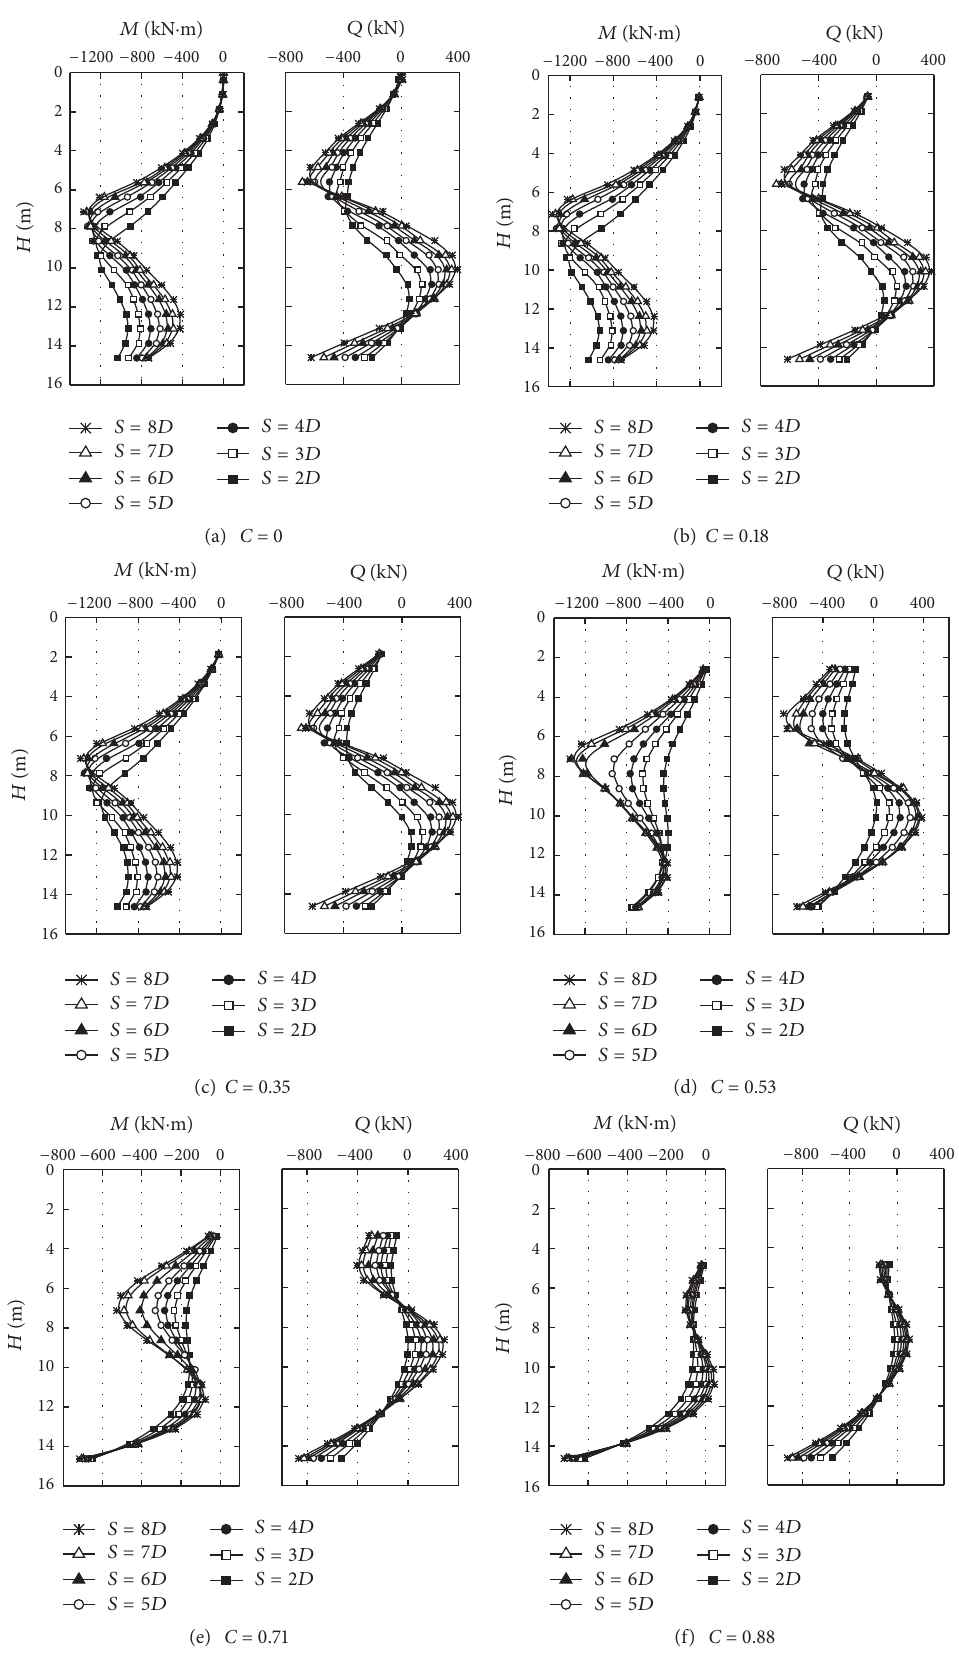
Figure 11: Truncated pile behavior characteristics for various pile